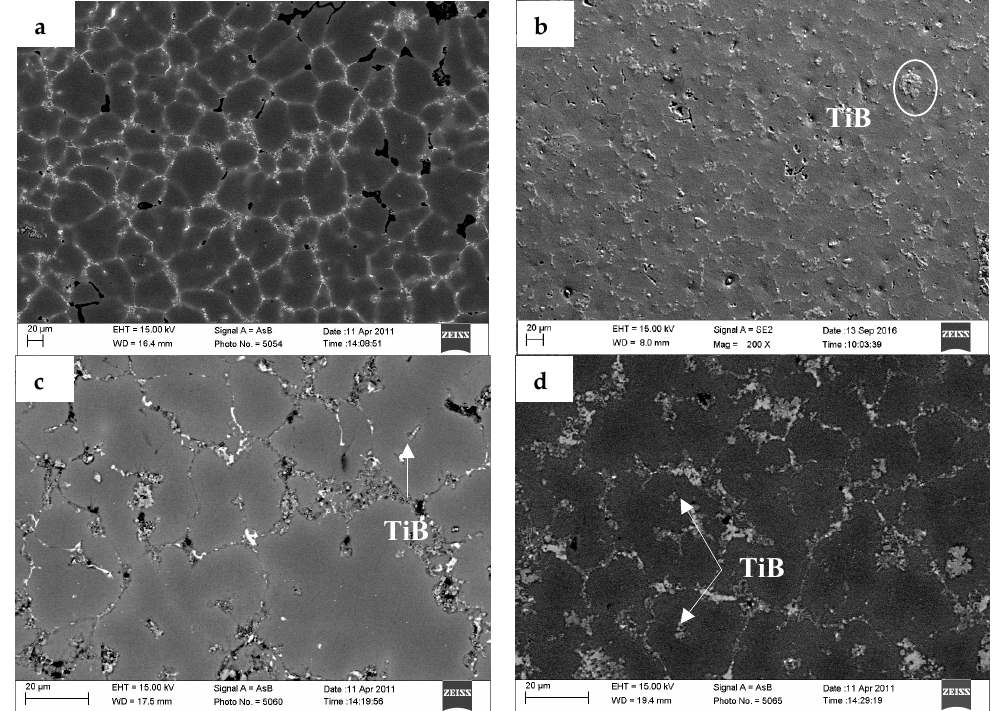
Figure 6. The microstructures of TiB 2 /7075 composites molten at 720 °C after being poured into the graphite mold. ( a ) 3.0% TiB 2 /7075; ( b ) 4.5% TiB 2 /7075; ( c ) 6.0% TiB 2 /7075; ( d ) 9.0% TiB 2 /7075.